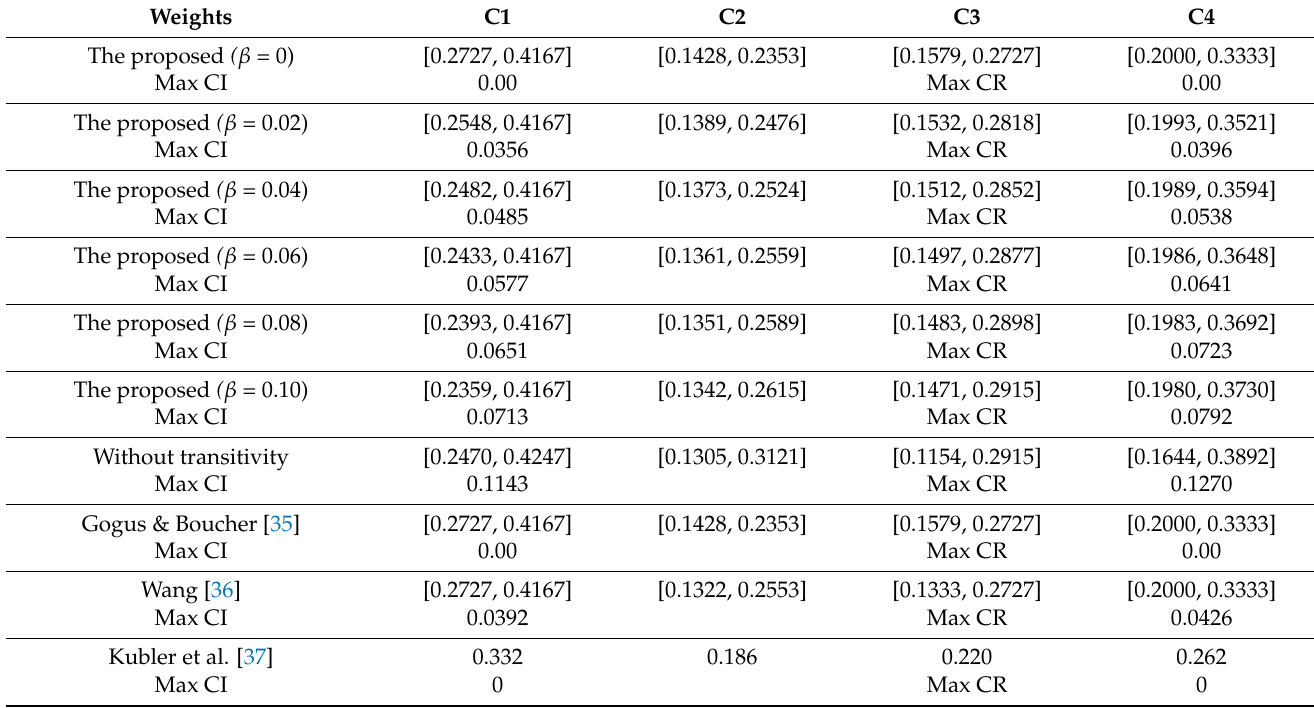
Table 4. Different FAHP results in Example